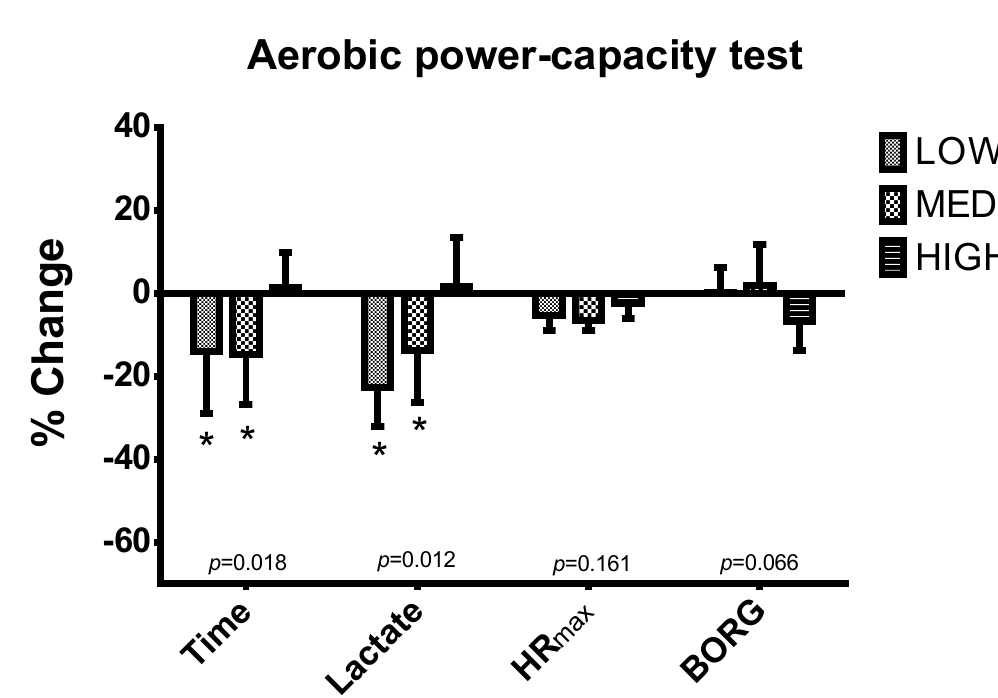
Figure 4. Percentage di ff erence of high intensity run capacity parameters between T1 and T2. * Significant di ff erences compared to HIGH using Mann Whitney u test ( p <